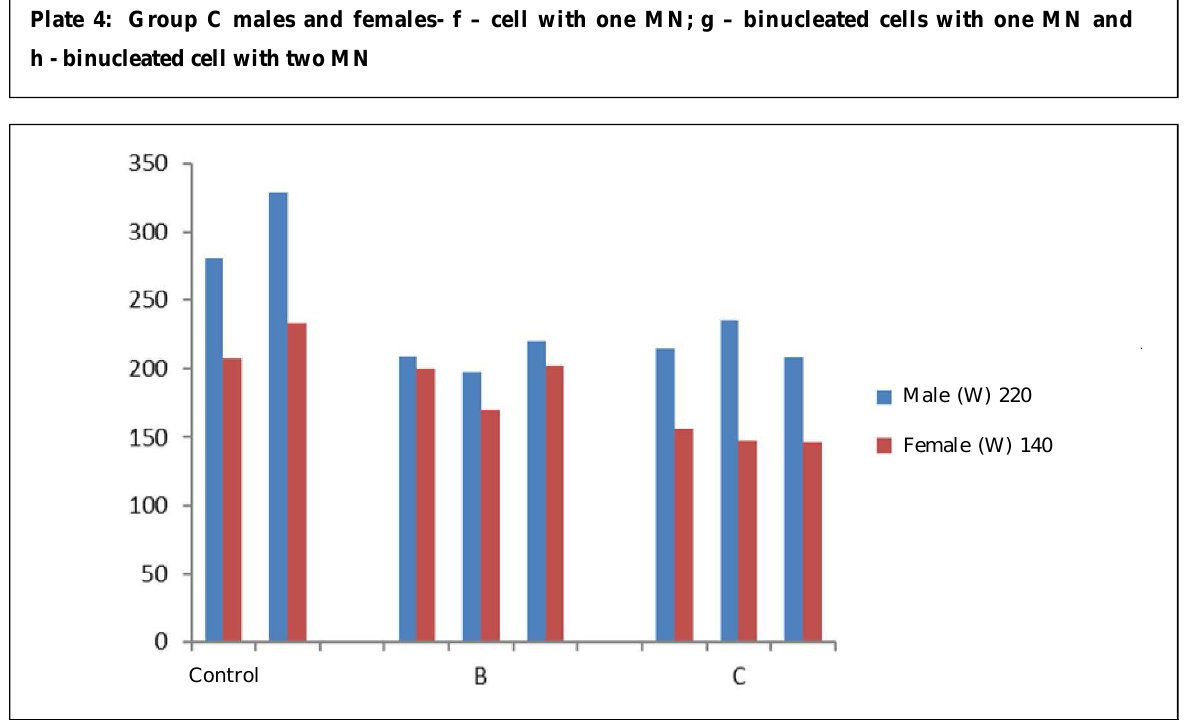
Figure 1: Bar chart for the distribution of male and female albino rats in the